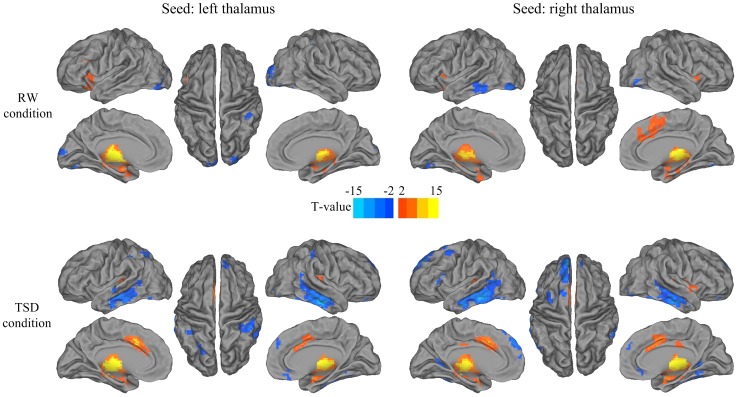
The whole-brain functional connectivity patterns of the left thalamus and right thalamus before and after the 36 h TSD.Brain regions with positive correlations are displayed in hot, while negative correlations are displayed in cold.